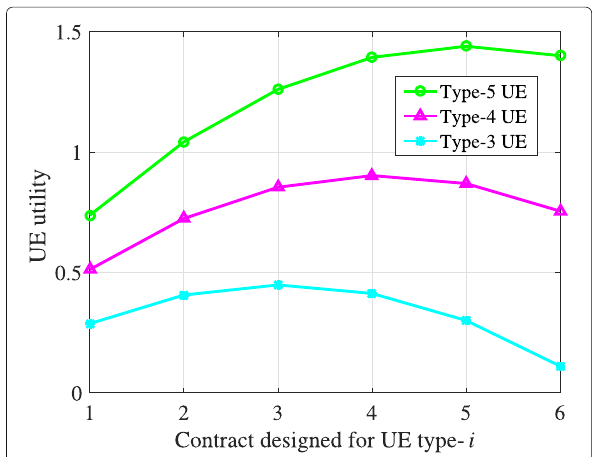
Fig. 5 UE utility versus the contract designed for UE type- i